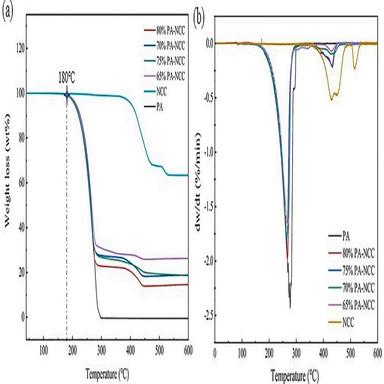
TG(DTG) curves of NCC and PA-NCC.